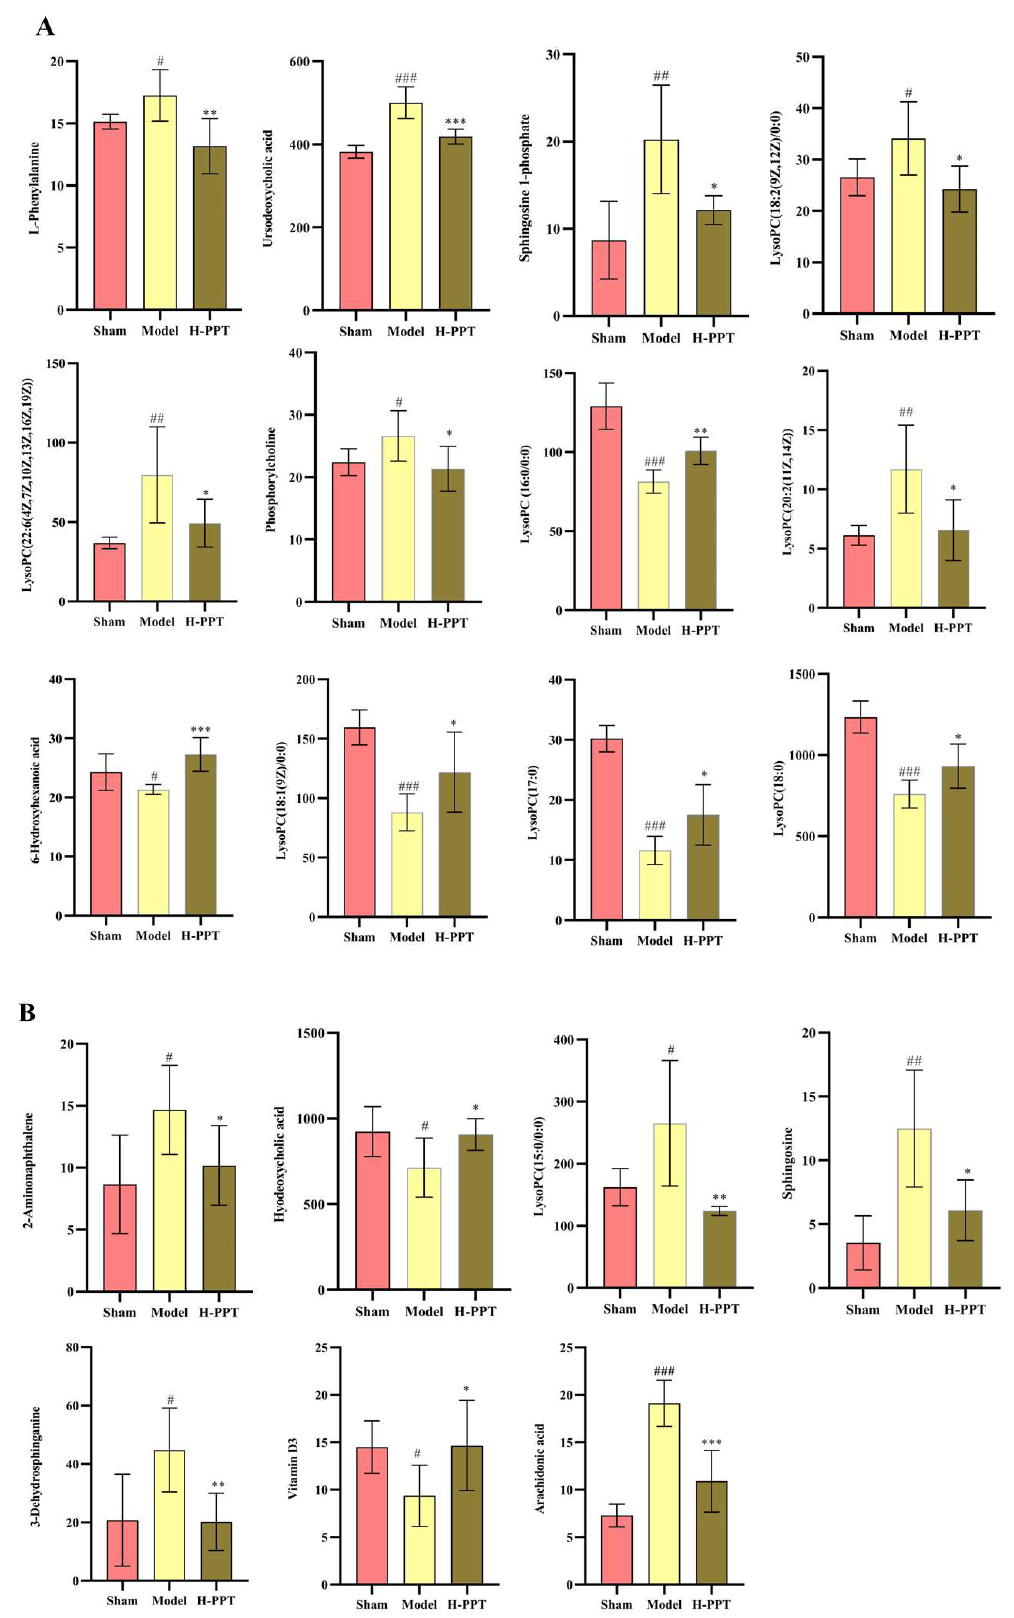
Figure 7. Each biomarker’s concentration in the sham, model, and H-PPT groups’ serum ( A ) and brain ( B ). Data are presented as means ± SD ( n = 6). Compared with control group, # p < 0.05, ## p < 0.01, ### p < 0.001; compared with model group, (* p < 0.05, ** p < 0.01, *** p < 0.001).